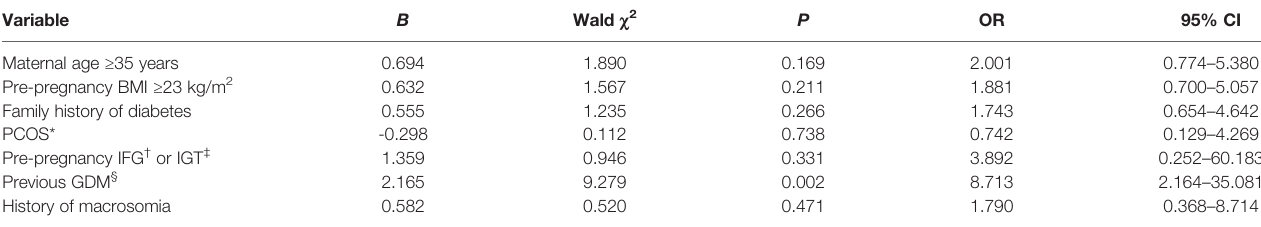
TABLE 4 | Multivariate logistic regression analysis of factors in fl uencing HIP diagnosis in late pregnancy.